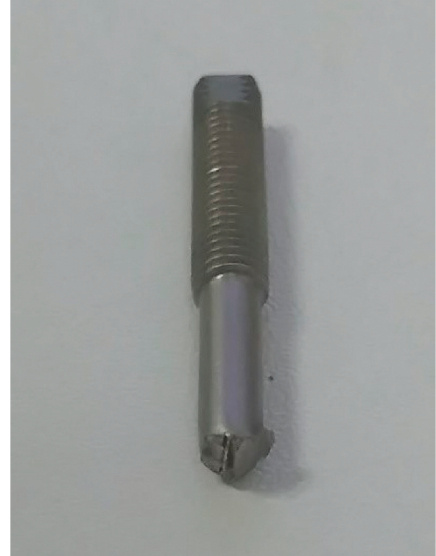
Figure 10: Photograph of a real cut of a connecting rod. Table 6: Numerical simulation results for a pyrotechnic cutter with a connecting rod with the diameter of 5mm for different spacing values. Spacing Diameter (mm)